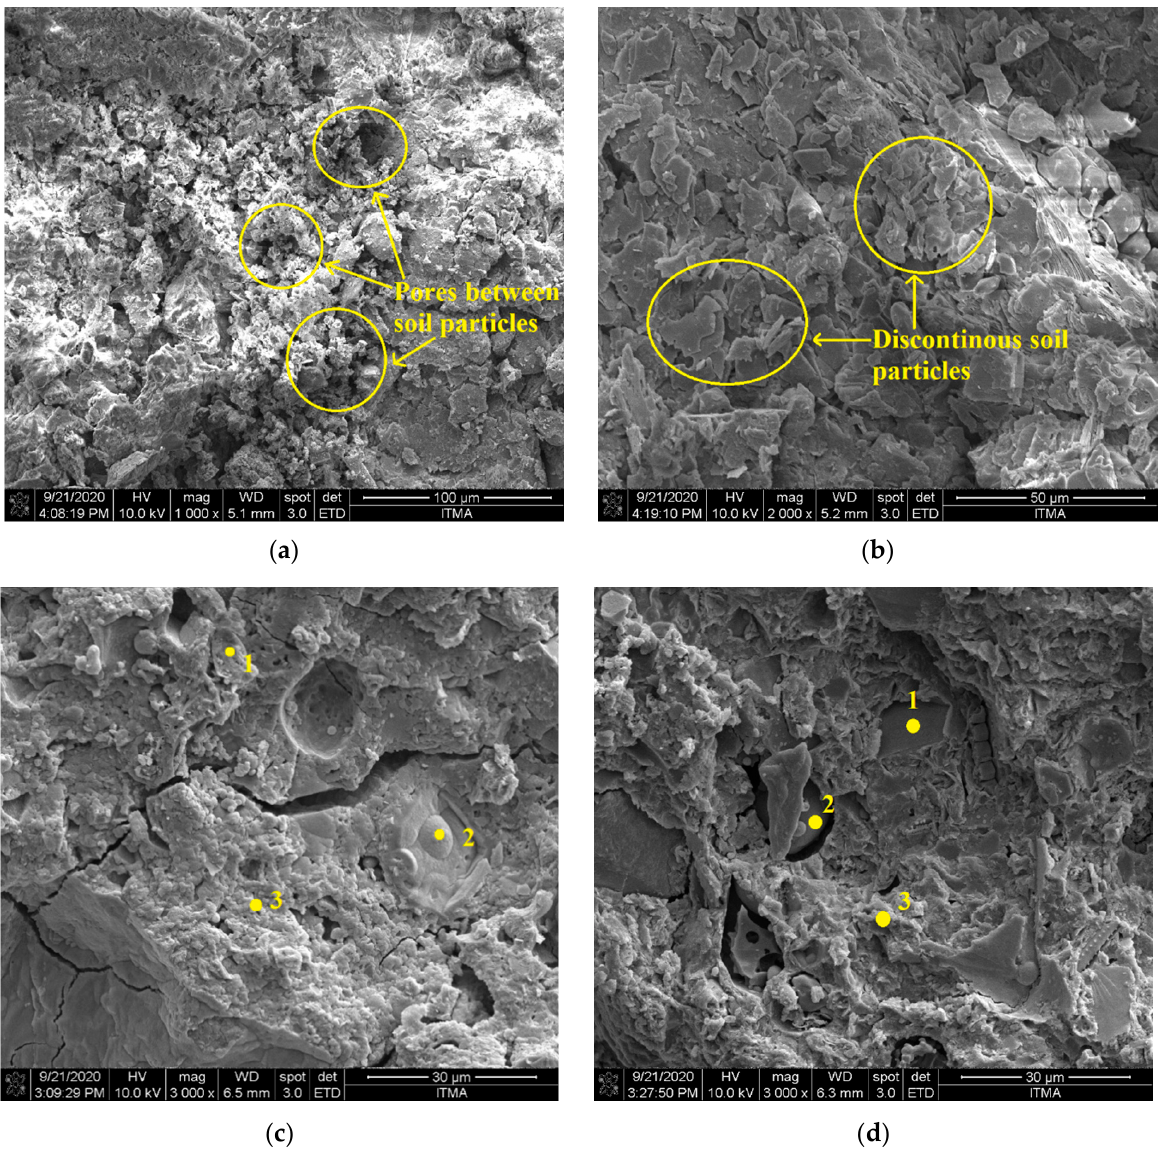
Figure 7. Field emission electron microscopic (FESEM) micrographs: ( a ) CL, ( b ) CH, ( c ) CL-G40PA, ( d ) CH-G40PA.